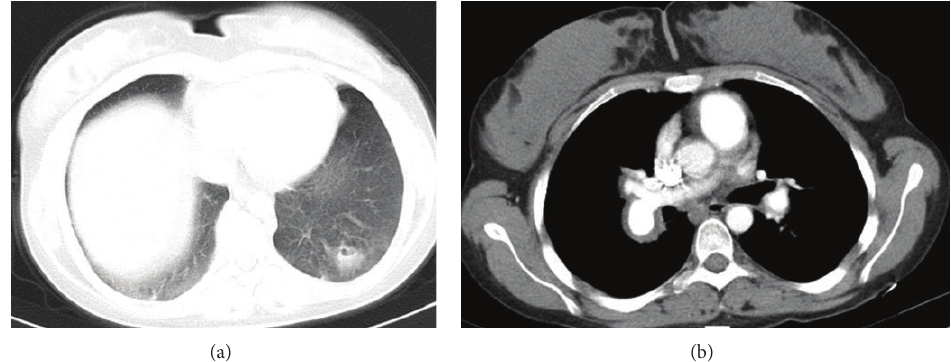
Figure 4: Minimisation of the consolidated substance related to the emboli on CT after the treatment (a), partial dissolution of the thrombus and minimisation of its PA diameter